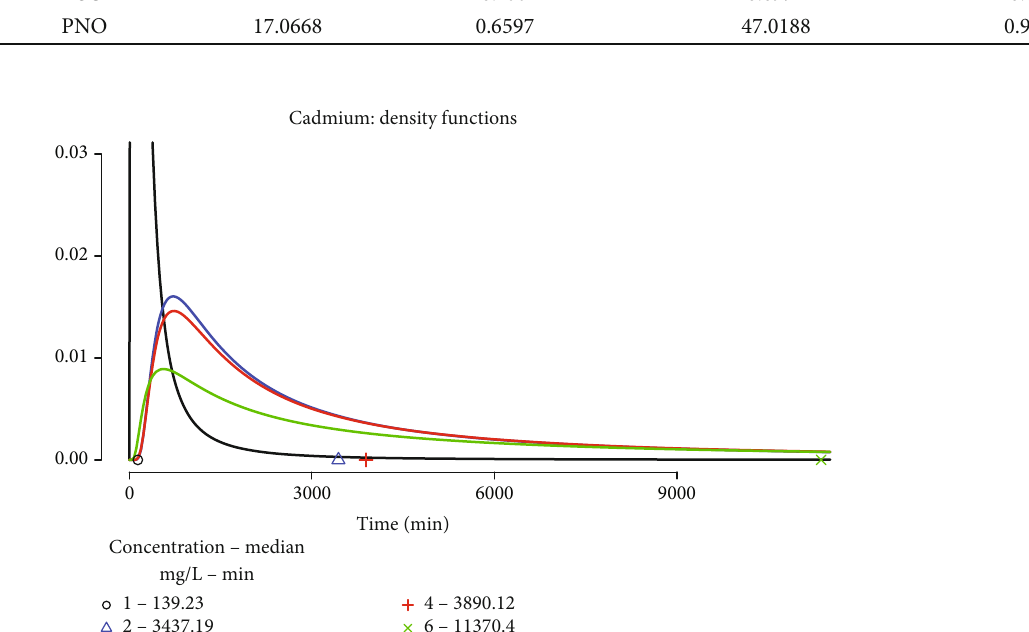
Figure 10: Density functions of the time ( t concentrations of 1, 2, 4, and 6 mg/L.